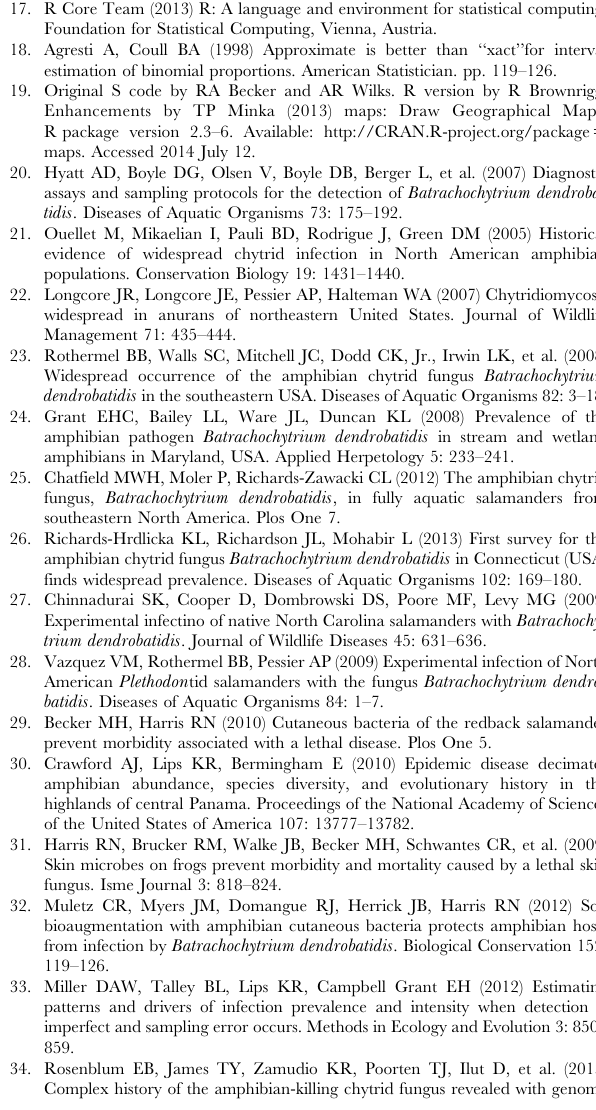
Table S1 Site and species summary of salamanders tested for Bd . Number in parentheses indicate samples tested for both Bs and ranavirus.